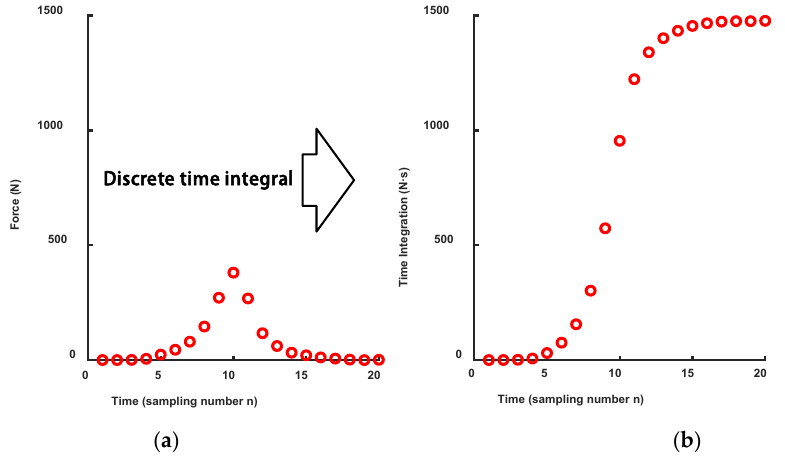
Figure 8. ( a ) Load-time history of impact load 1 (after zoom in). ( b ) Load-time discrete integration of impact load 1.